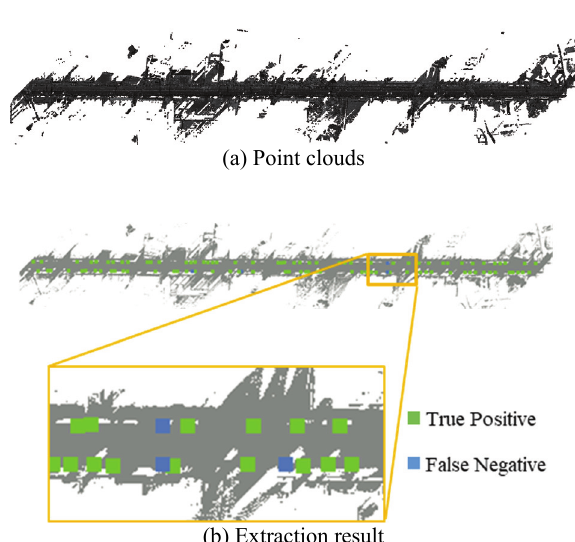
Table 4 . Extraction result of roadside trees